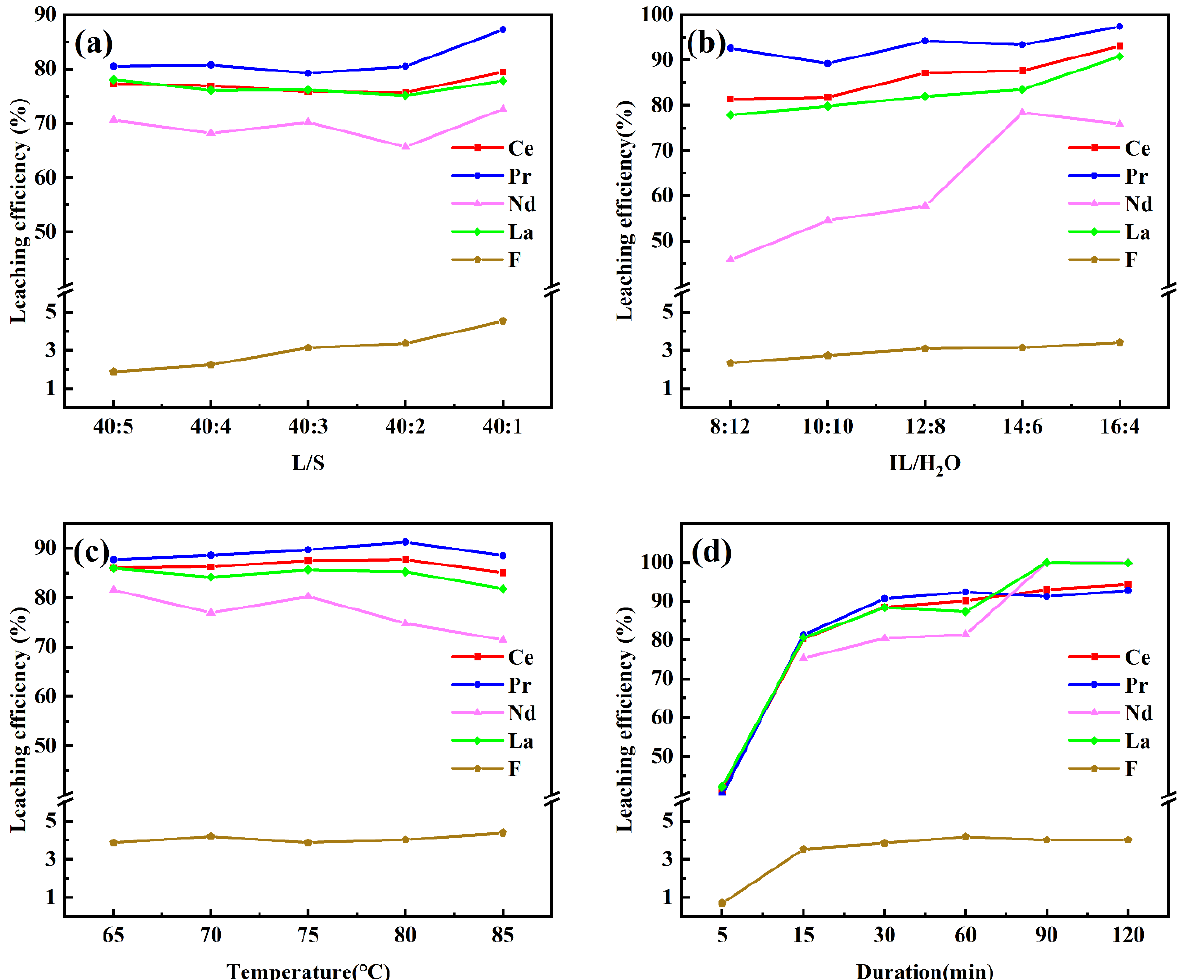
Figure 6. Effects of reaction volume ratio of ( a ) S/L ratio (the leaching condition: 75 °C, IL/H 2 O = 14:6, 60 min), ( b ) [Hbet][Tf 2 N] – H 2 O (the leaching condition: 75 °C, L/S = 40:1, 60 min), ( c ) temperature